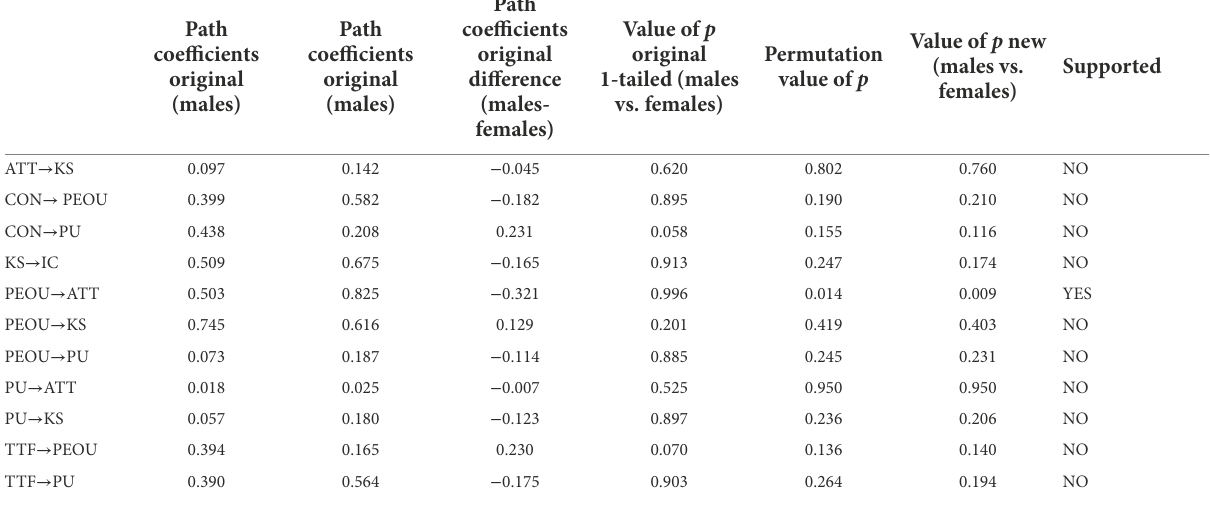
TABLE 13 Assessment of group